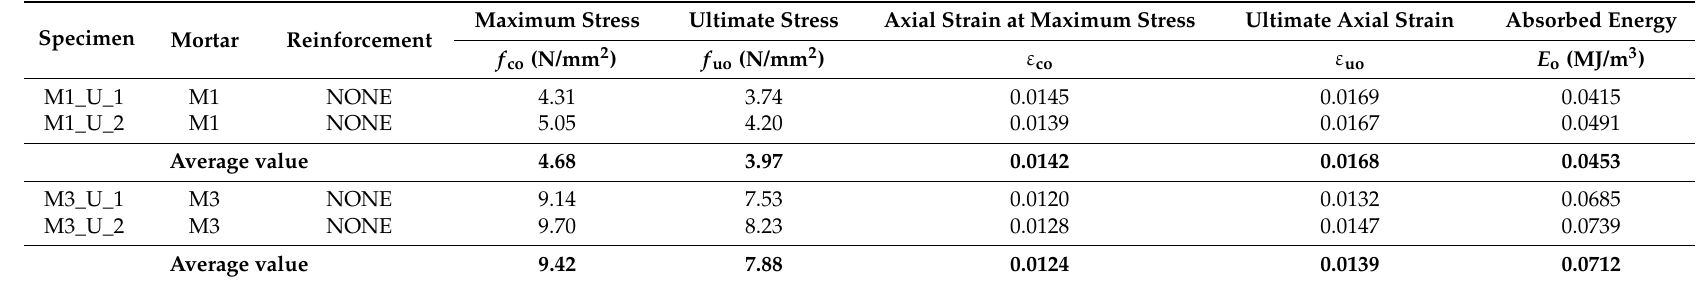
Table 1. Details of unconfined brick masonry columns (control specimens) and key results.